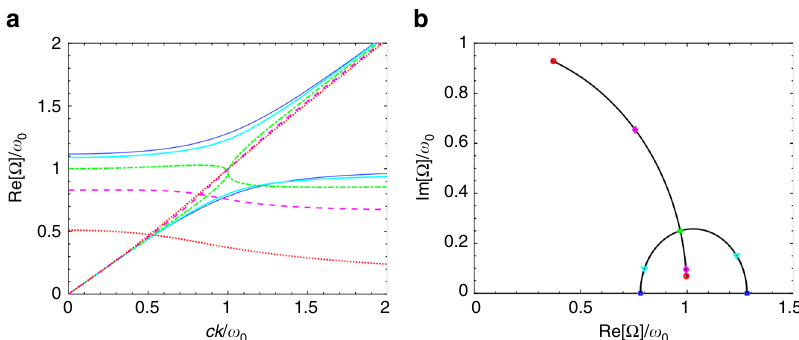
Fig. 1 Eigenmodes of the Lorentz model. a Dispersion of the two polaritonic branches from the Lorentz model in Eq. (3), for ω c = 0.5 ω 0 and γ L = 0 (thin blue lines), 0.5 ω 0 (solid cyan lines), ω 0 (dash-dotted green lines), 1.5 ω 0 (dashed magenta lines) and 2 ω 0 (dotted red lines). The transition between the strong coupling regime presenting an anticrossing (blue and cyan lines) and the weak one in which the polaritonic modes cross (magenta and red lines), with the green line at the edge between the two, is cleary visible. b Trajectories drawn by the eigenfrequencies in the complex plane, at resonance ck = ω 0 , when varying γ L . Coloured squares, triangles, dots, diamonds and circles mark the increasing values of γ L used in a